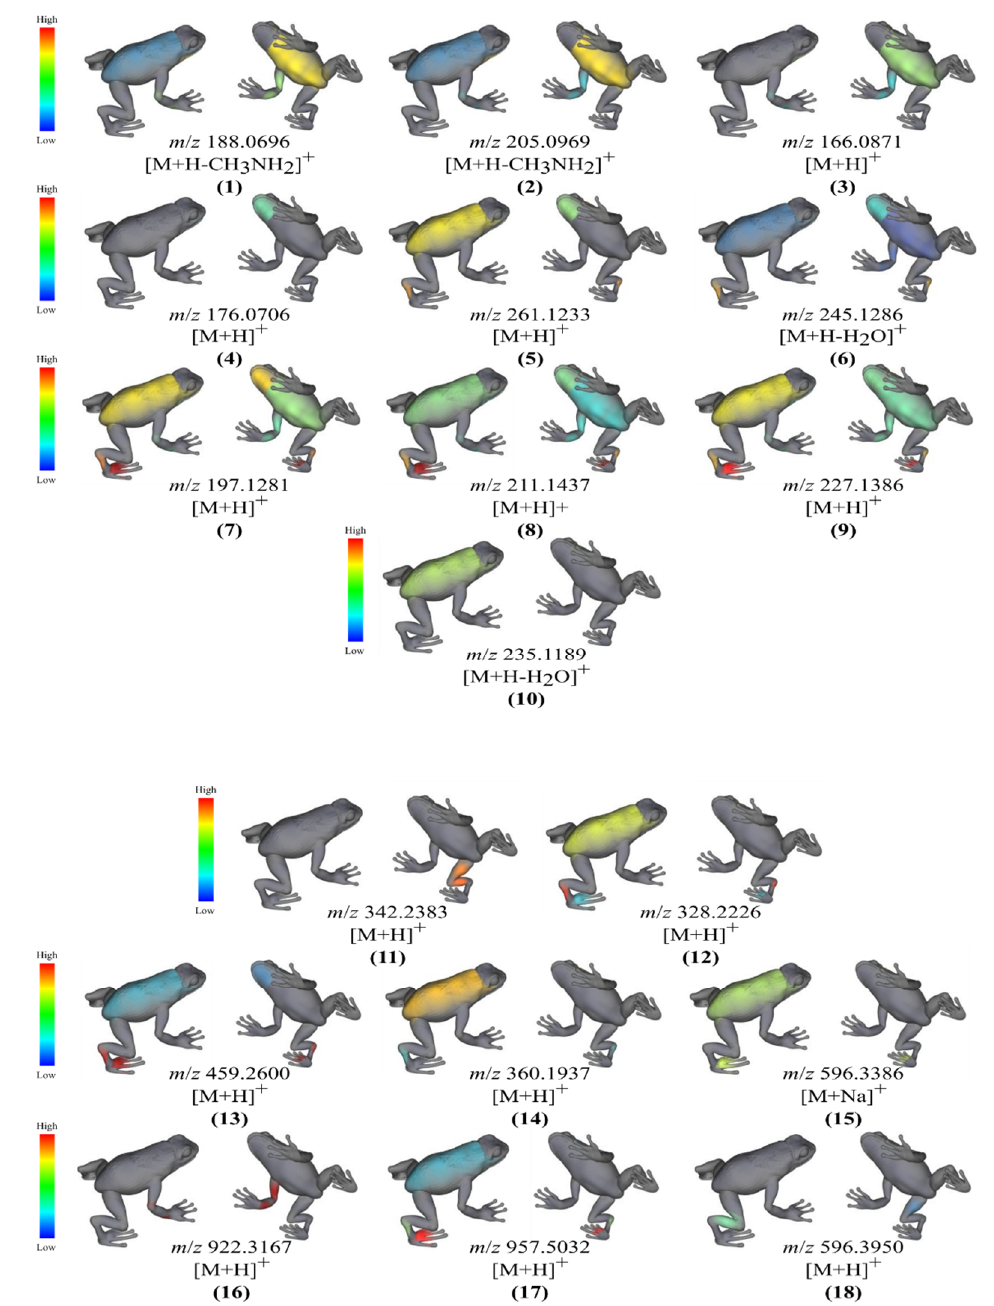
Figure 4. Molecular cartography of annotated metabolites identified from bacterial isolates sampled from the skin surface of C. panamansis . These metabolites were annotated as tryptophan derivatives (1,2), phenylalanine (3), 3-indoleacetic acid (4), diketopiperazines (5–10) and peptides (11–18). Intensities are related to the abundance of the specialized metabolites in the samples at each body part. Red represents the highest abundance while blue represents the lowest abundance.